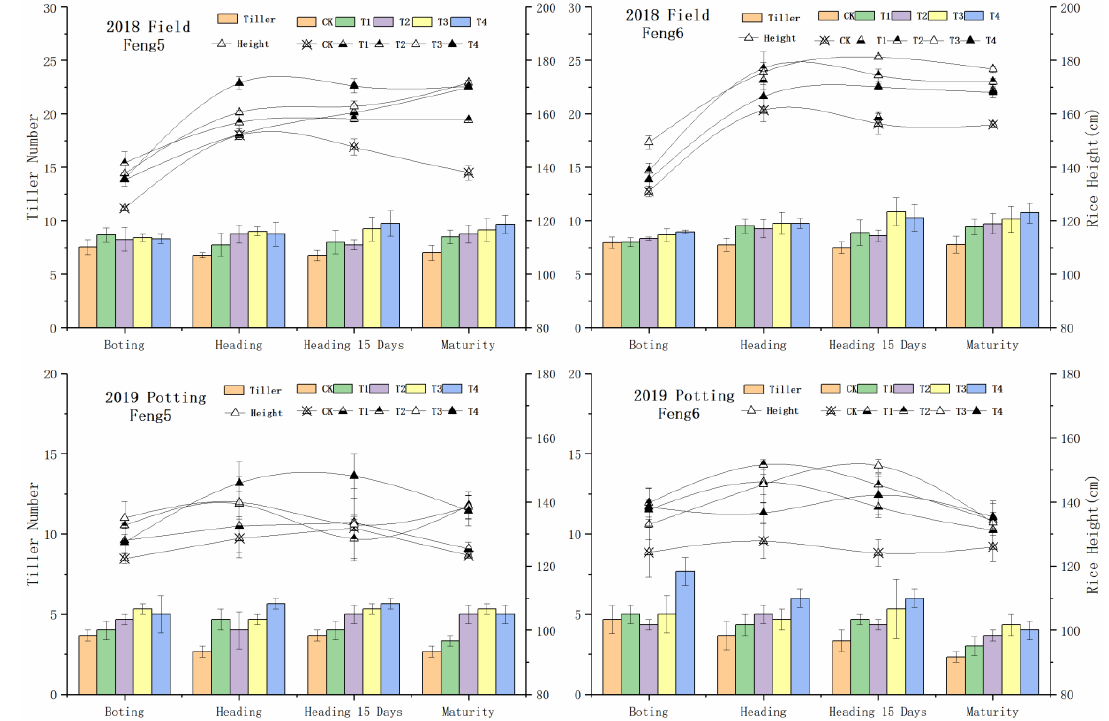
Figure 3. Changes in plant height and tillering of giant rice under nitrogen treatment.